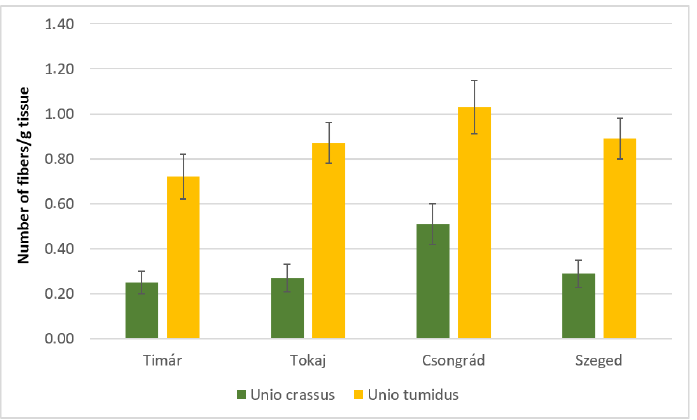
Figure 3. Number of fibers/g soft tissue (n = 10) of Unio tumidus and Unio crassus collected at settle- ments of Tímár, Tokaj, Csongrád, and Szeged. The standard deviations are marked on the bars.